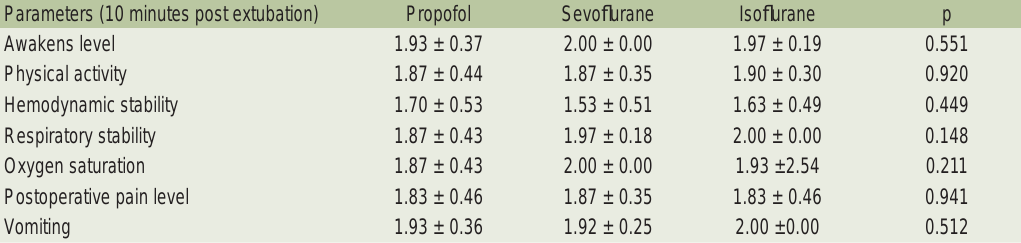
TABLE 5. White fast tracking scoring system, measurements preformed ten minutes post Parameters (10 minutes post extubation)